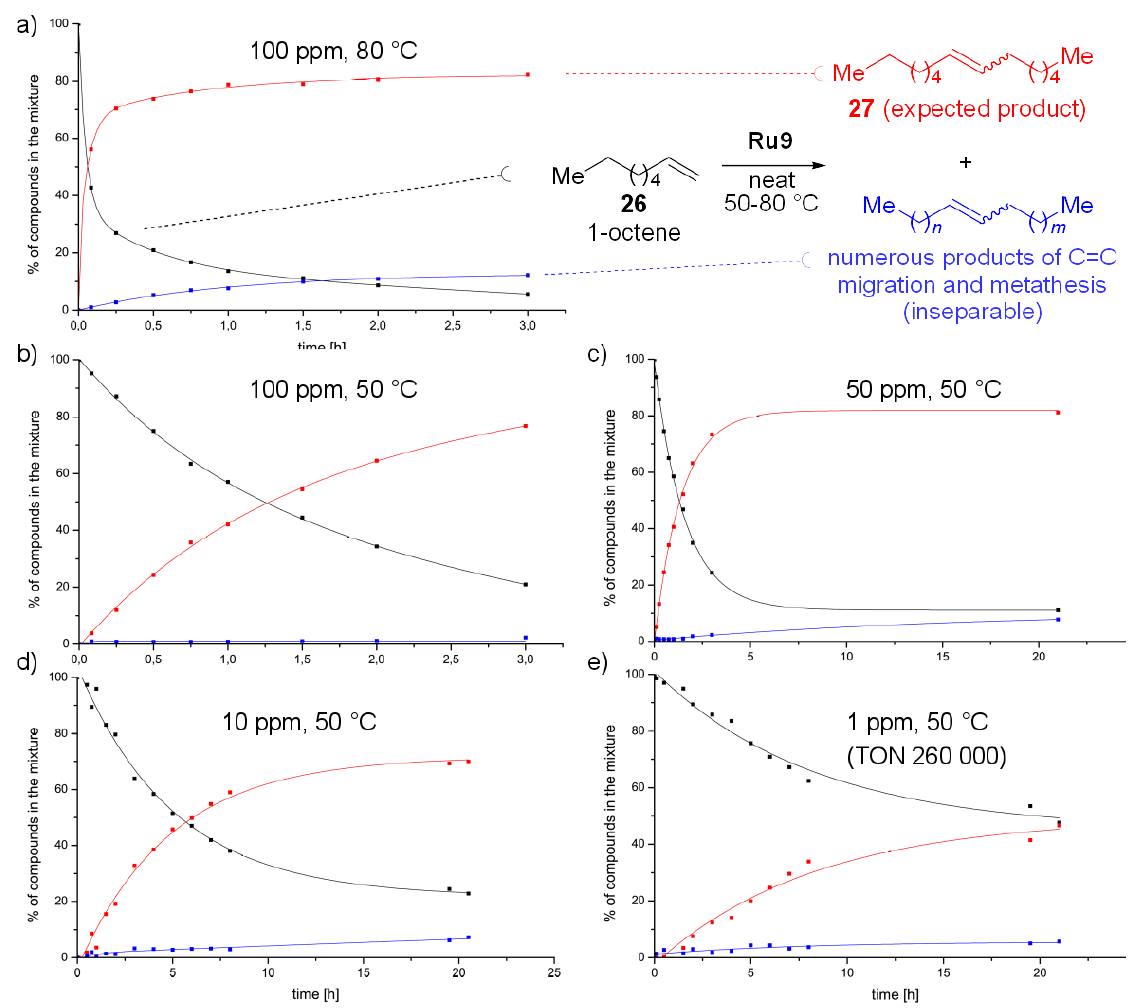
Figure 7. Self-cross metathesis (self-CM) of 1-octene. ( a ) Ru9 100 ppm, 80 °C. ( b ) Ru9 100 ppm, 50 °C. ◦ C. ( d ) Ru9 10 ppm, 50 ◦ C. ( e ) Ru9 1 ppm, 50 ◦ C. Lines are as a visual aid ( c ) Ru9 50 ppm, 50 °C. ( d ) Ru9 10 ppm, 50 °C. ( e ) Ru9 1 ppm, 50 °C. Lines are as a visual aid only. ( c ) Ru9 50 ppm, 50